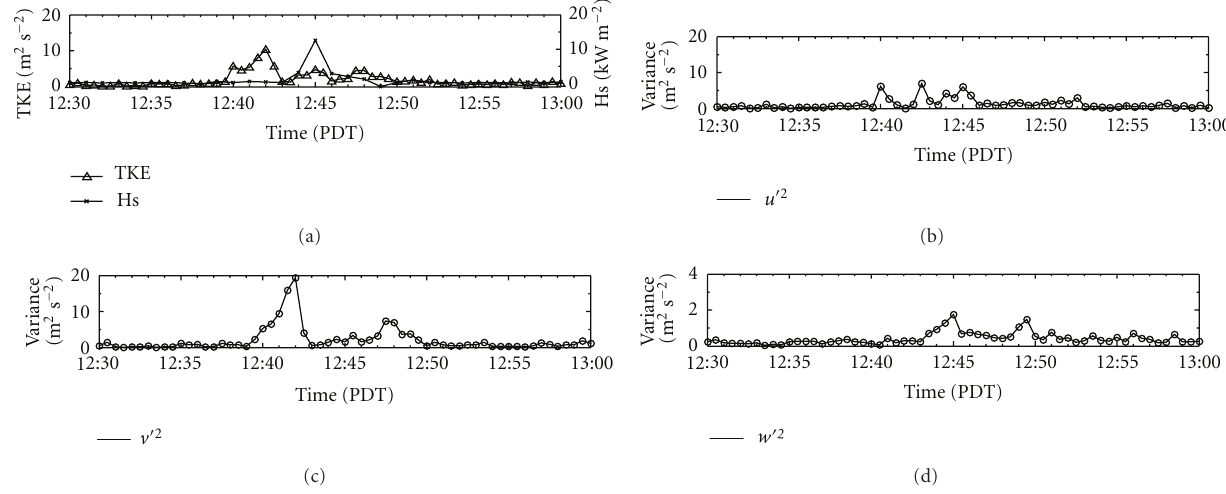
Figure 10: Time series of (a) 30s averaged turbulence kinetic energy and 1min averaged sensible heat flux, (b), (c), and (d) 30 s averaged u , v , and w velocity component perturbation variances,